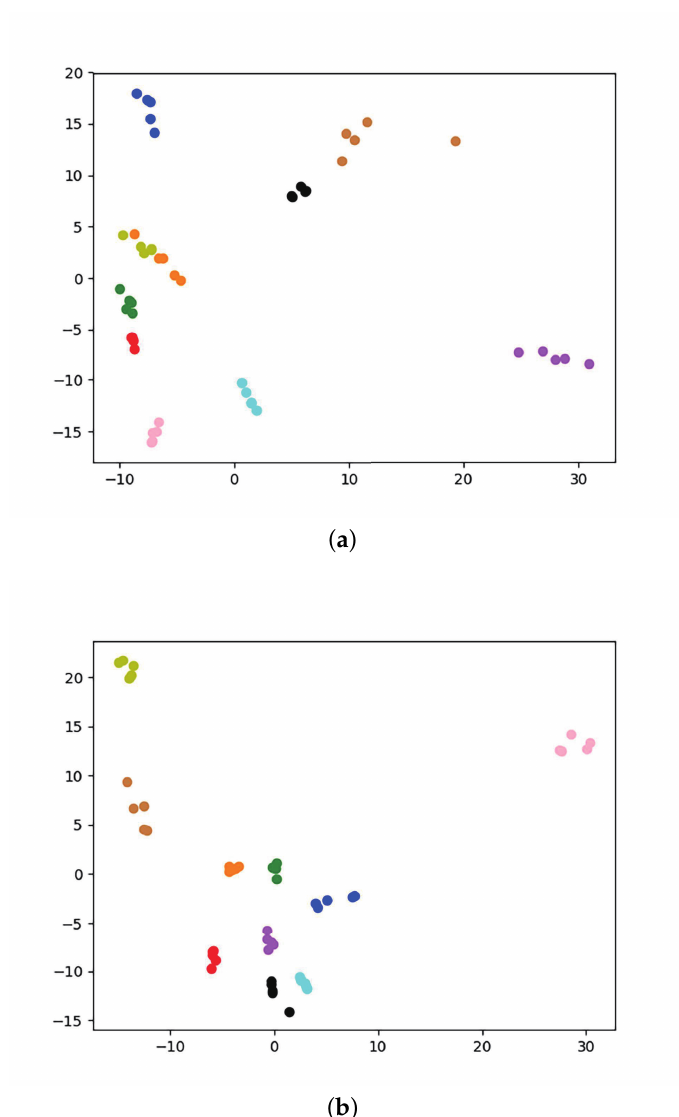
Figure 4. Scatter distribution of attention convolution mapped in 2-dimensional space. ( a ) The scatter distribution without attention convolution; ( b ) The scatter distribution after introducing attention